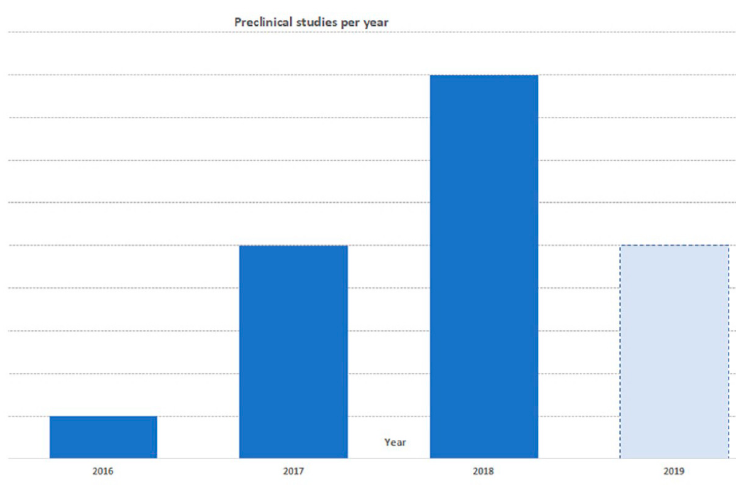
Figure 3. Published preclinical articles per year.